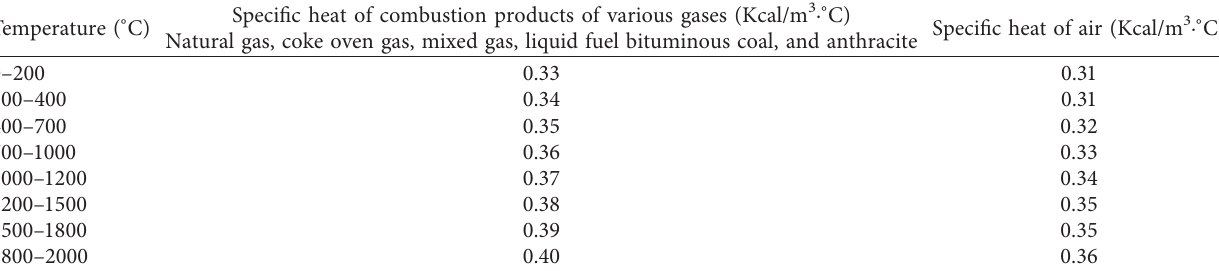
Table 2: Specific heat table of air flue gas.